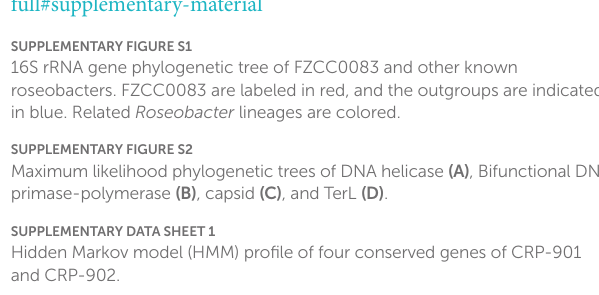
SUPPLEMENTARY FIGURE S1 16S rRNA gene phylogenetic tree of FZCC0083 and other known roseobacters. FZCC0083 are labeled in red, and the outgroups are indicated in blue. Related Roseobacter lineages are colored. SUPPLEMENTARY FIGURE S2 Maximum likelihood phylogenetic trees of DNA helicase (A) , Bifunctional DNA primase-polymerase (B) , capsid (C) , and TerL (D) . SUPPLEMENTARY DATA SHEET 1 Hidden Markov model (HMM) profile of four conserved genes of CRP-901 and CRP-902.